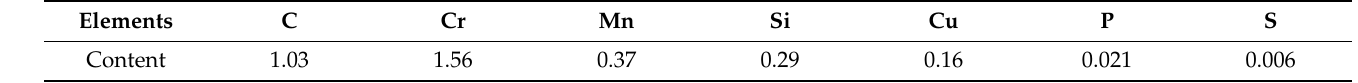
Table 1. Chemical compositions of ZGCr15 steel(wt.%).